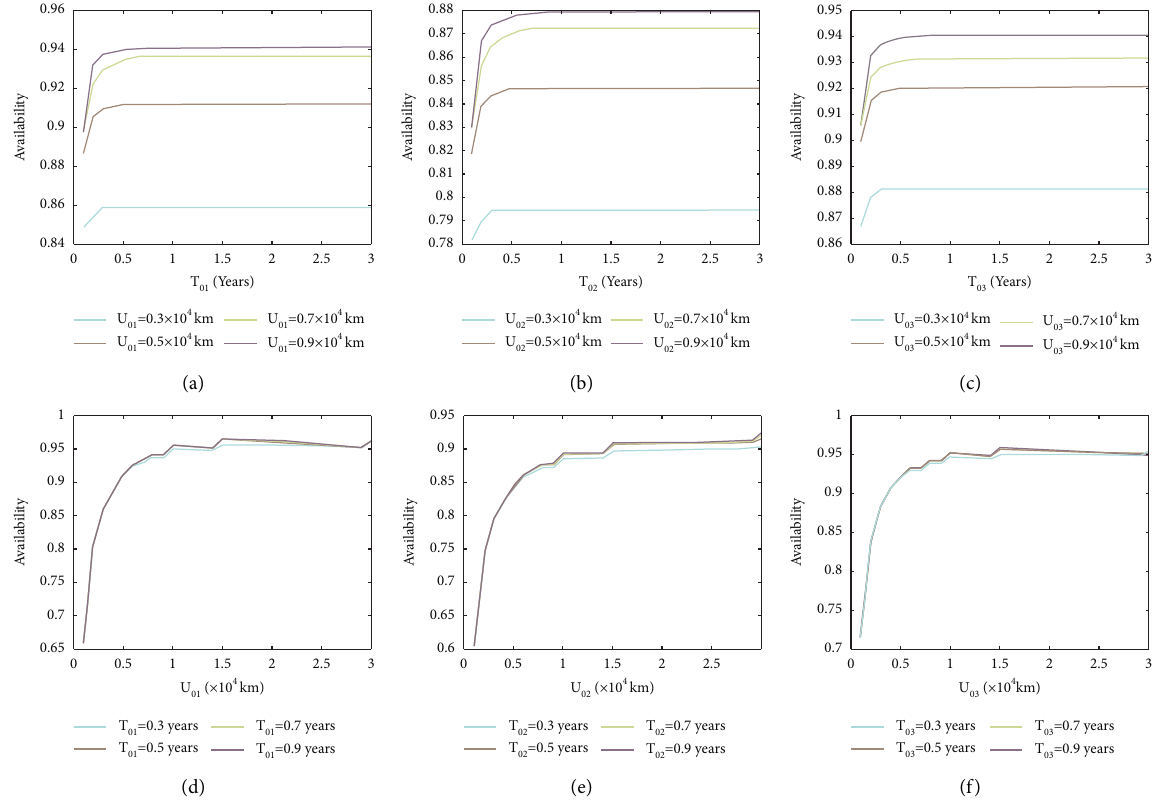
Figure 12: Dimension reduction analysis of availability change of